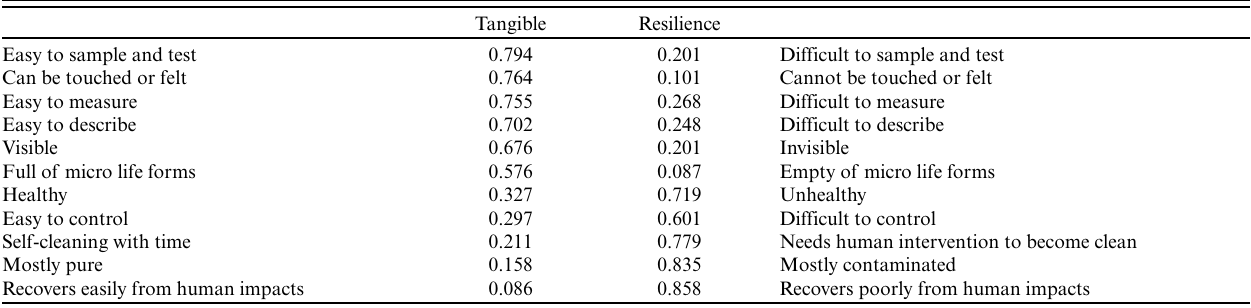
Table 5 . Perceived tangibility and resilience. Survey 2 provided a two-factor solution (tangibility and resilience) and explained 59% of the total variance, 30% under the factor “tangibility” and 29% of the variance explained by the factor “resilience”.